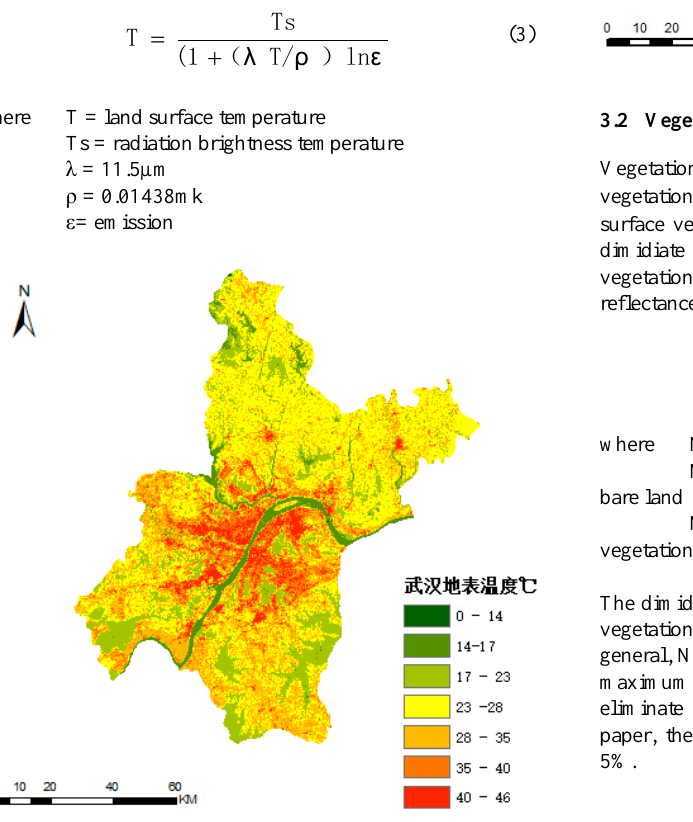
Figure 1. Surface temperature inversion of Wuhan In order to highlight comparability and relativity, it is necessary to normalize the surface temperature. As a result, the map of heat island intensity is formed.